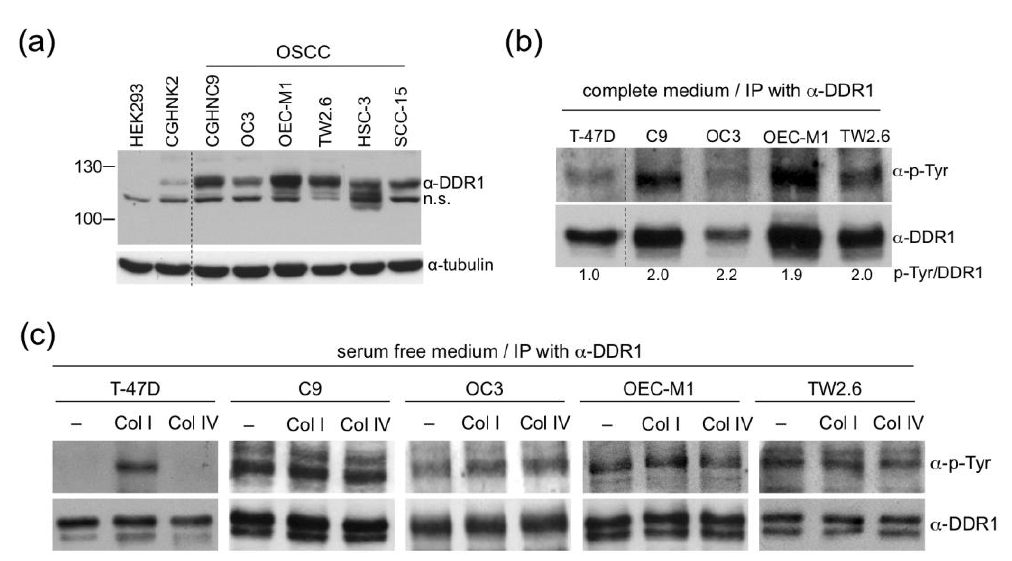
Figure 3. Constitutive phosphorylation of DDR1 in OSCC cells. ( a ) Western blot analysis of relative DDR1 expression levels in HEK293, CGHNK2, and six OSCC cells. Thirty µ g protein lysates from each sample were used. α -tubulin served as an internal control. n.s., a nonspecific polypeptide cross-reactive to α -DDR1 antibody. ( b ) Total protein extracts of T-47D and OSCC cells were immunoprecipitated with the DDR1 antibody followed by western blot analysis using antibodies against p-Tyr or DDR1. The ratio of phosphorylated DDR1 intensity to that of total DDR1 was quantitated using ImageJ, with T-47D set to one. Similar results were obtained from two independent experiments; one set of data is shown. ( c ) T-47D and OSCC cells were cultured in a serum starved